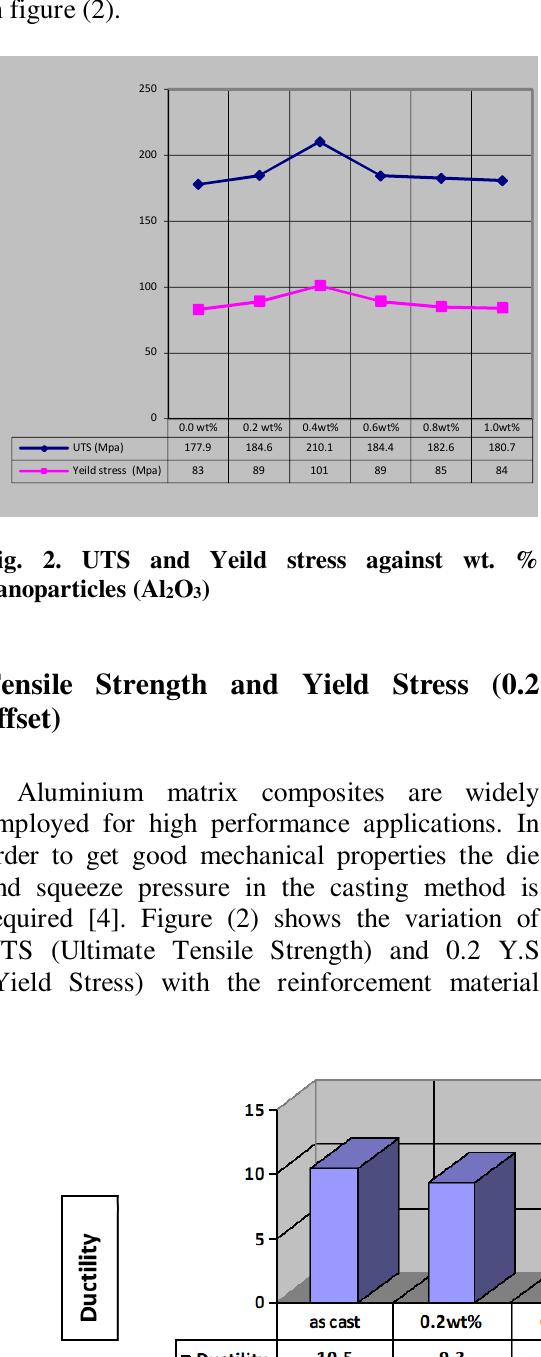
Fig. 3. The elongation vs. with various Al 2 O 3 wt.